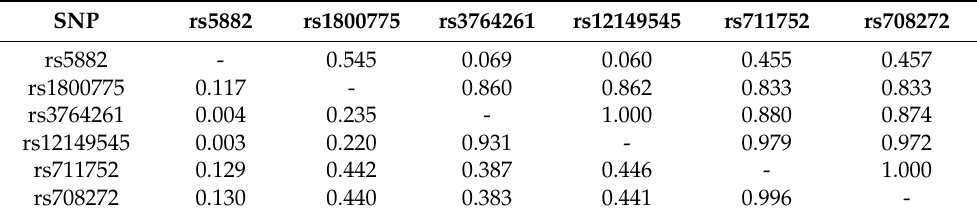
Table 6. Linkage disequilibrium test for the six CETP SNPs.